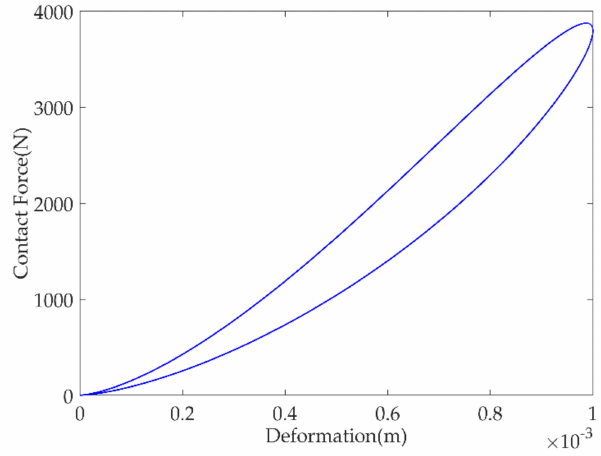
Figure 5. Contact force curve of